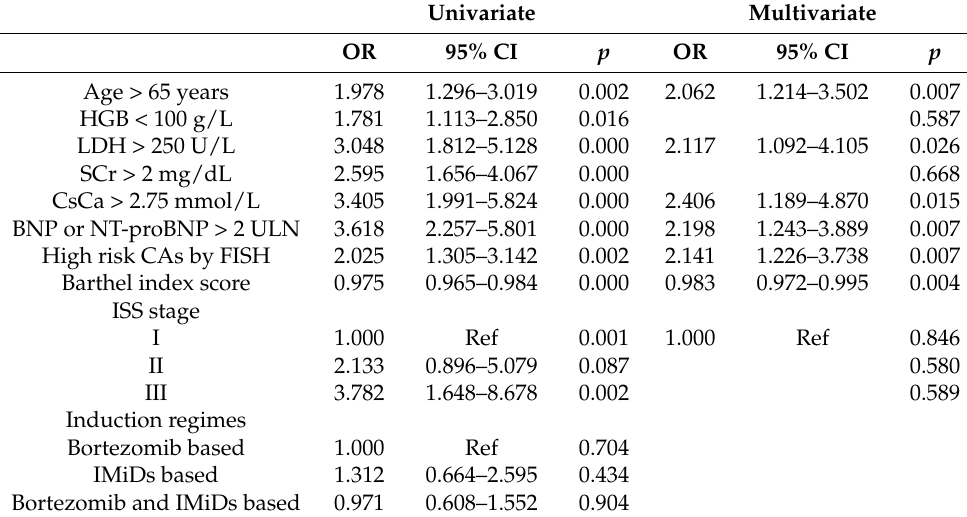
Table 3. Logistic regression analysis (univariate and multivariate) for short survival